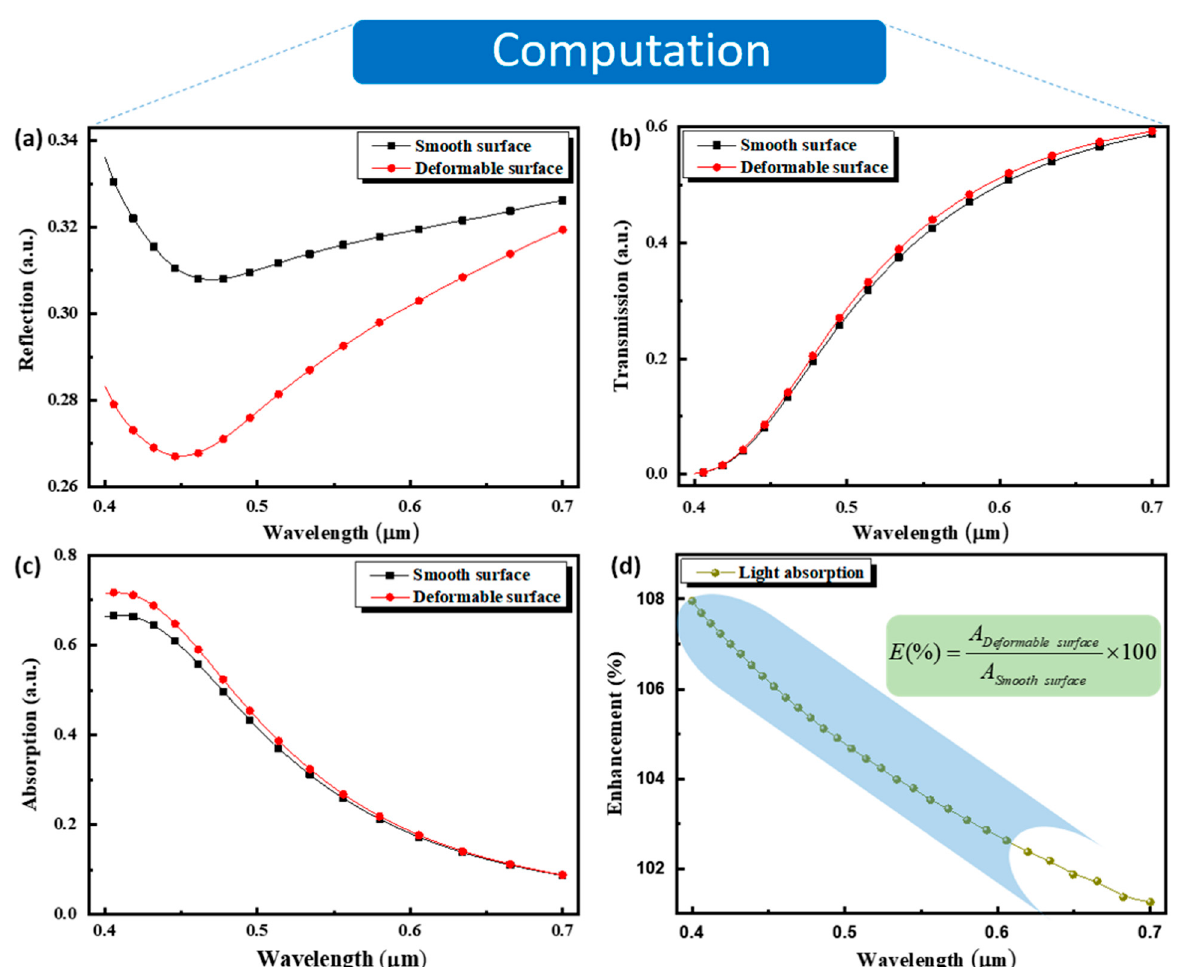
Figure 3. Lumerical finite-difference time-domain (FDTD) simulation for the ( a ) reflection spectra, ( b ) transmission spectra, ( c ) absorption spectra, and ( d ) light absorption enhancement of the photodetection devices based on the deformable and smooth nanofilm surfaces.